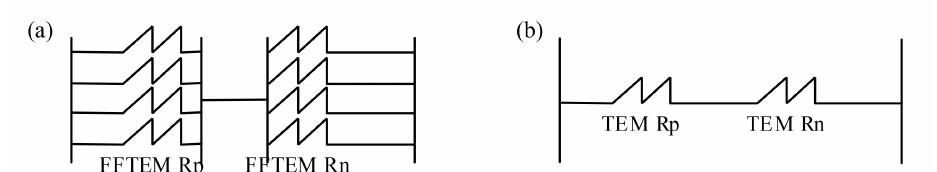
Figure 7. ( a ) Equivalent resistance for FFTEM module. ( b ) Equivalent resistance for TEM